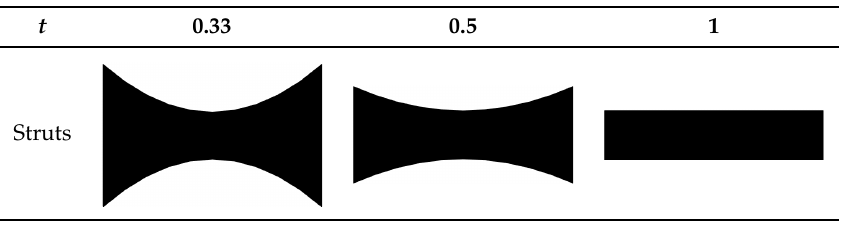
Table 1. Illustration of the struts with different diameter ratios.